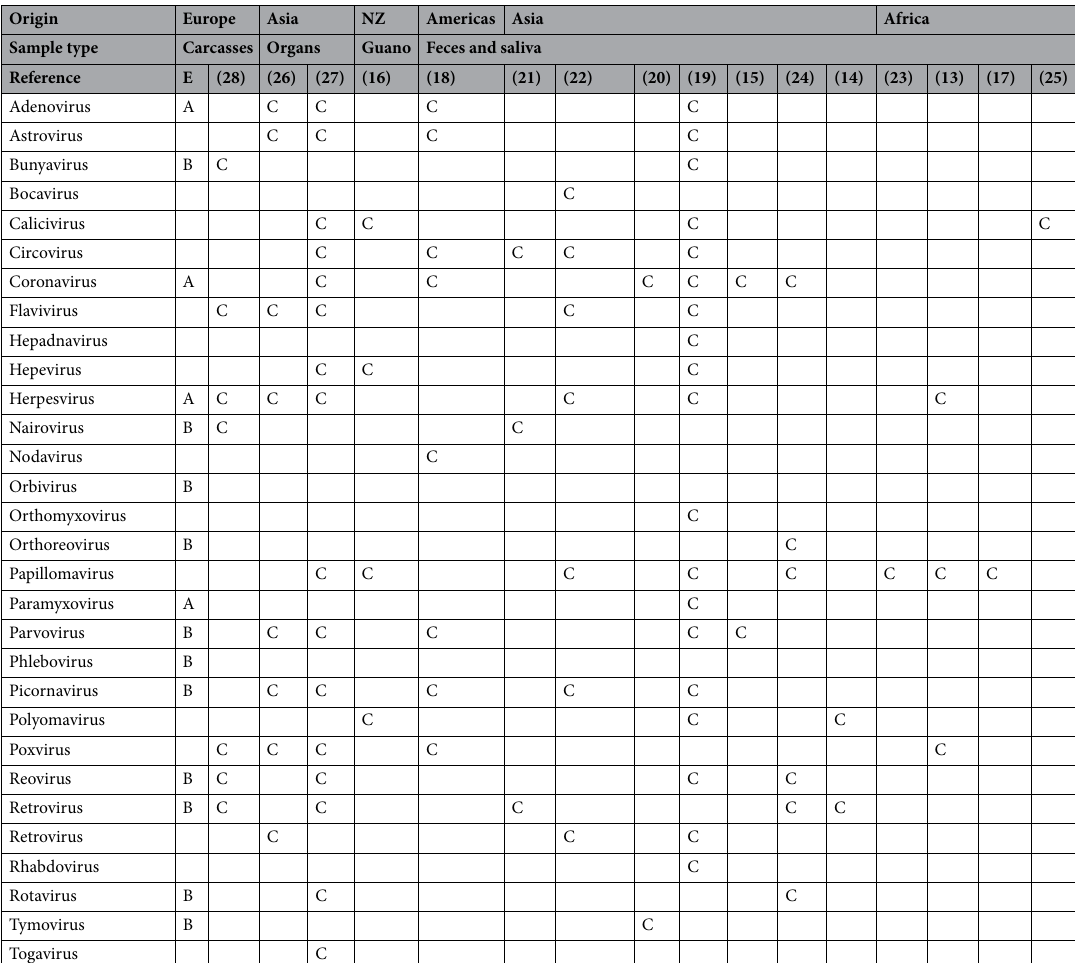
Table 1. Comparison of results from virus discovery studies conducted. The viral sequences obtained by family-specific PCR are marked with “A” and viral sequences obtained by virome sequencing are marked with “B”. Adenovirus and reoviruses were also isolated. The “C” indicates the finding of the respective viruses found by other studies. E the results from this study, NZ New